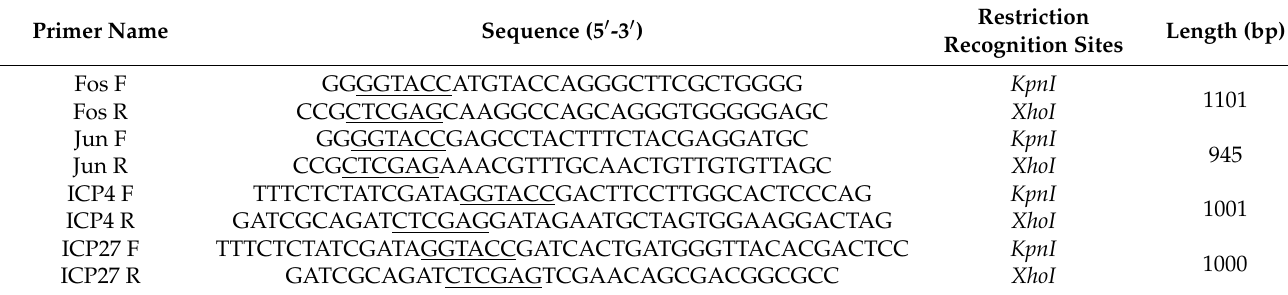
Table 1. Primer sequence for construct